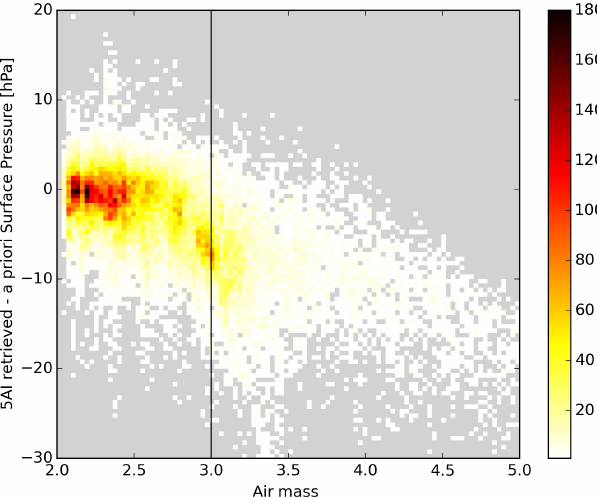
Figure 2. Distribution of target and nadir 5AI retrievals passing sur- face pressure, blended albedo, and reduced χ 2 r filters according to air mass and difference between retrieved and prior surface pres- sures. Grey areas denote bins for which no 5AI retrieval is